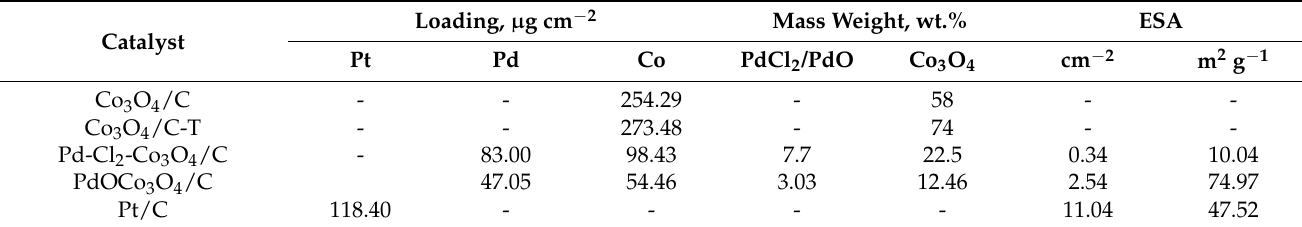
Table 1. Physical characterization of the investigated catalysts.